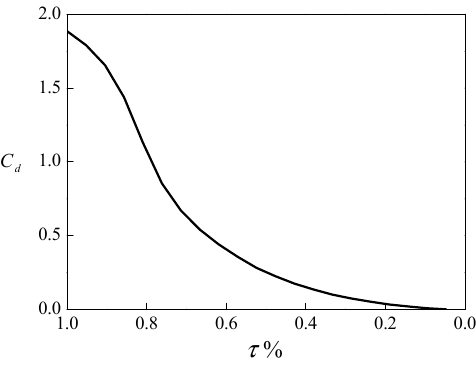
Figure 9. Discharge coefficient of the gate.